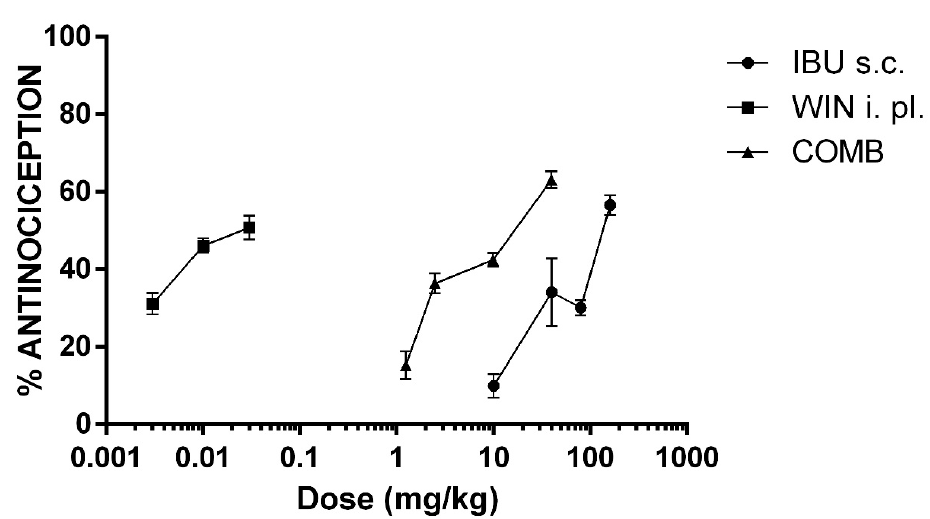
Figure 1. The dose–response curves (DRC) of the antinociceptive effect of ibuprofen (IBU, 10, 40, 80, and 160 mg/kg, s.c.), WIN 55,212-2 (WIN, 3, 10, and 30 µg/i.pl.), and the combination of both drugs (COMB). For COMB, each drug was administered by their respective route. The mean ± the SEM is plotted with six repetitions for each dose.